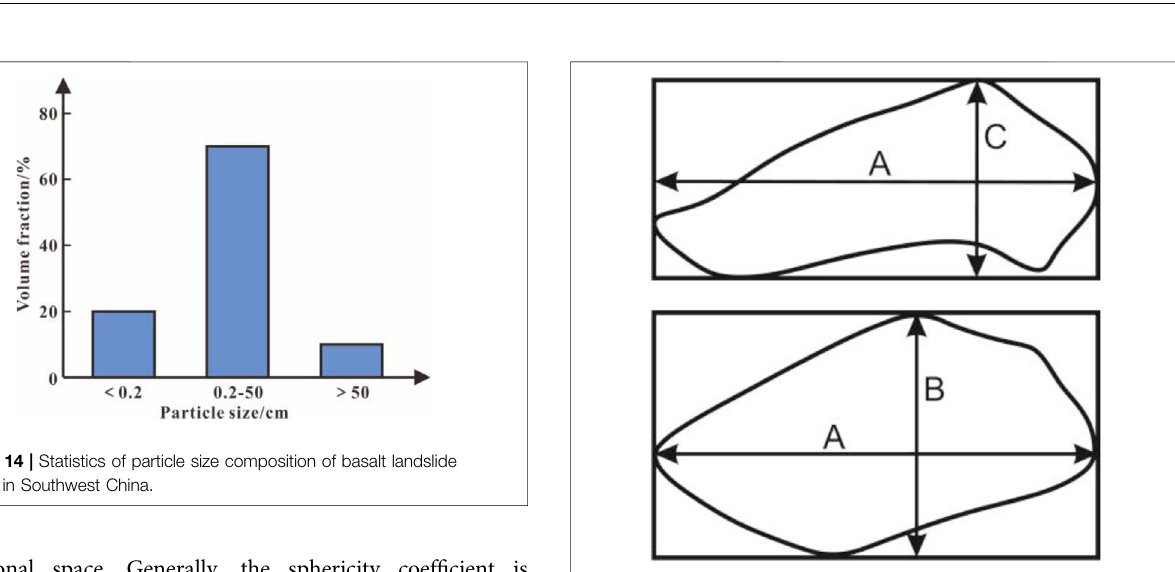
FIGURE 13 | Basaltic bedrock is exposed in the landslide source. (A) Columnar joints are developed in basaltic rocks. (B) The degree of rock fragmentation and cracking is high. (C) Fault fracture zone is exposed near the shear outlet of the landslide. (D) The attitude of bedrock in the source area.